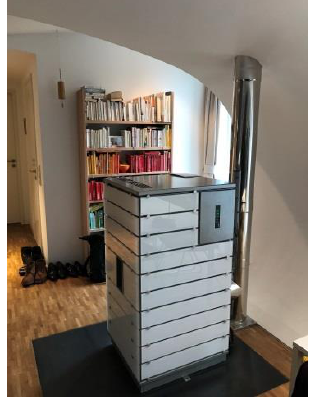
Fig. 2. Wood pellet boiler. Author: Cesar